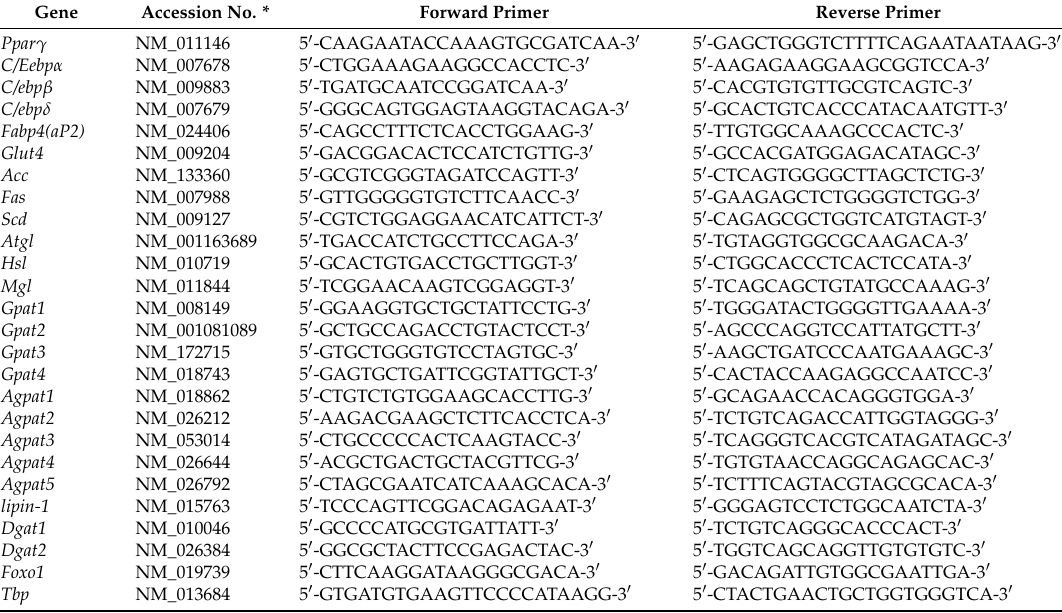
Table 1. Nucleotide Sequences of Primers Used in